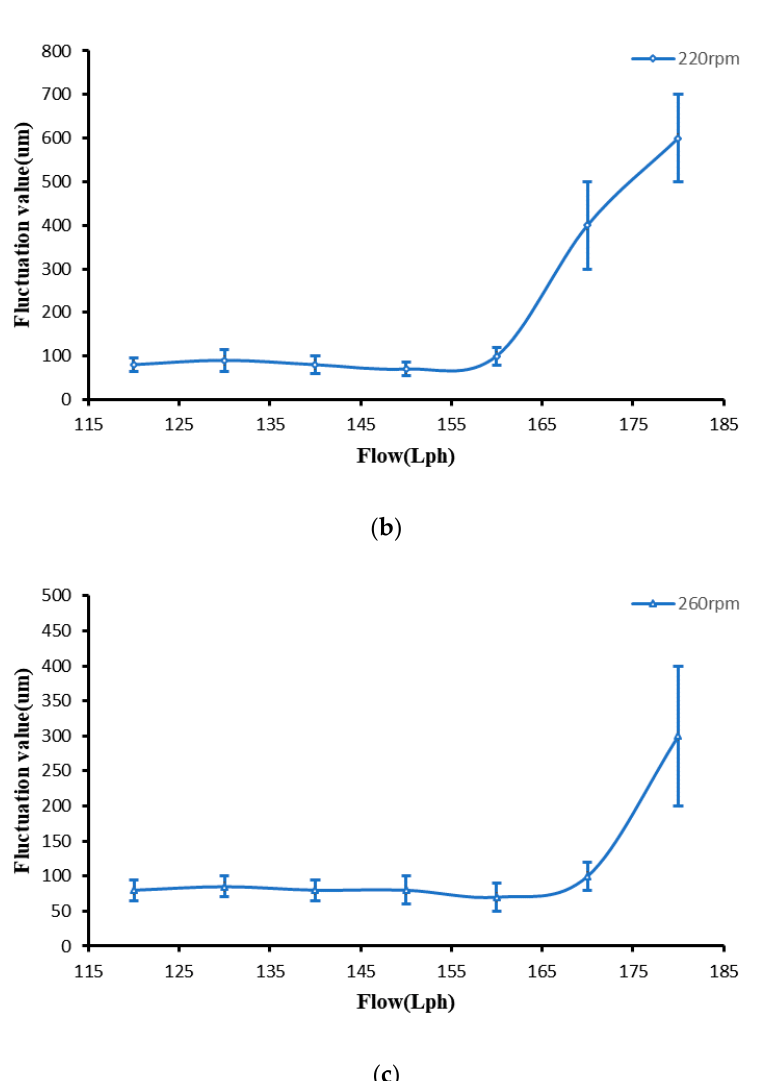
Figure 13. Variation of ribbon fluctuation with magnetorheological fluid flow. ( a ) Rotating speed 180 rpm. ( b ) Rotating speed 220 rpm. ( c ) Rotating speed 260 rpm.